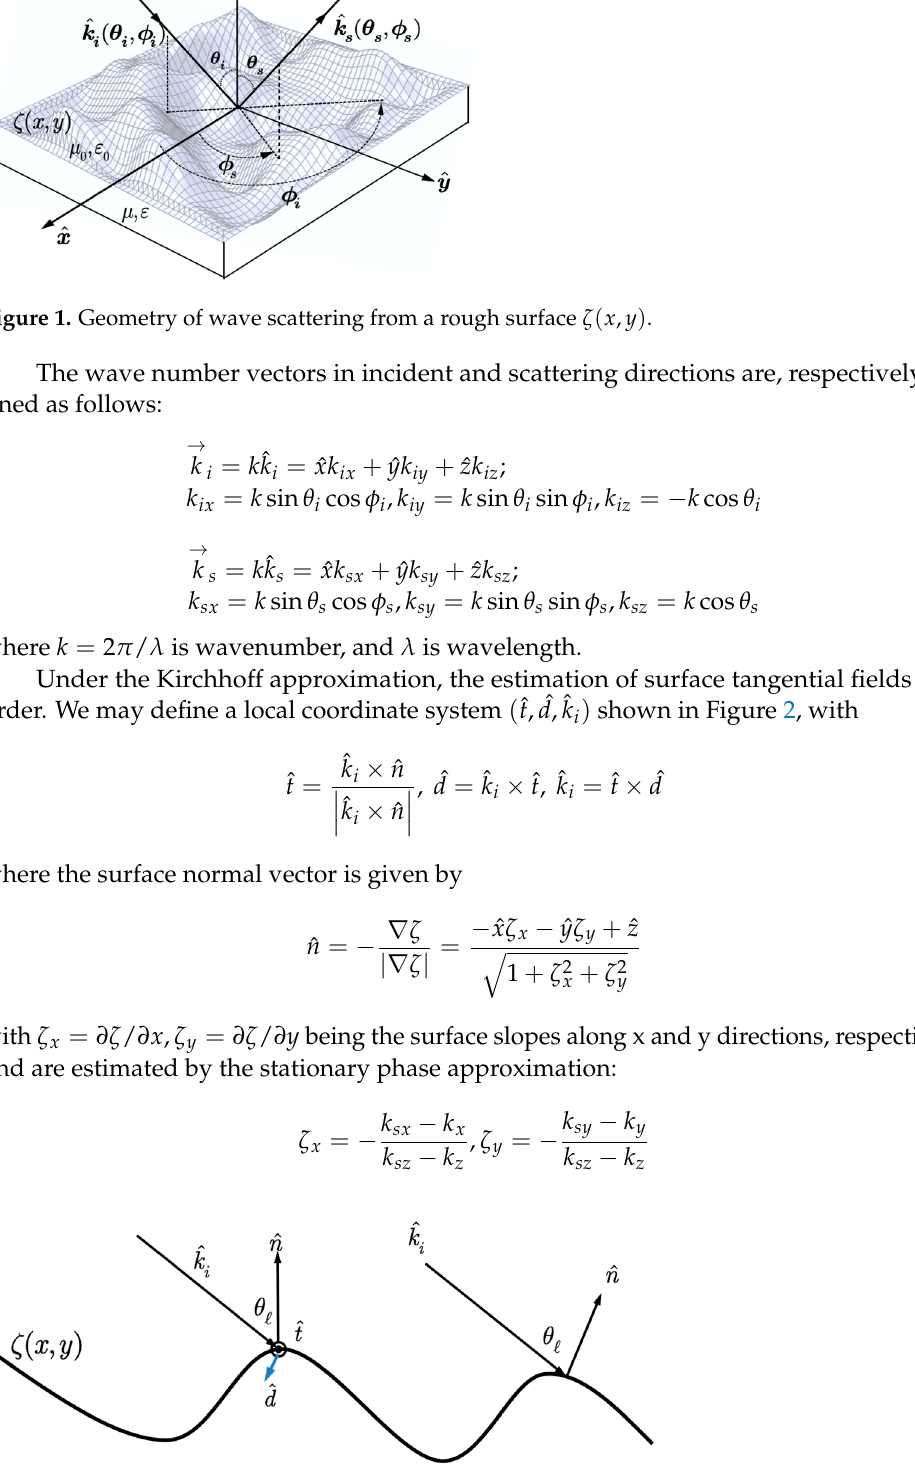
Figure 2. A local orthonormal coordinate ( ˆ t , ˆ d , ˆ k i )